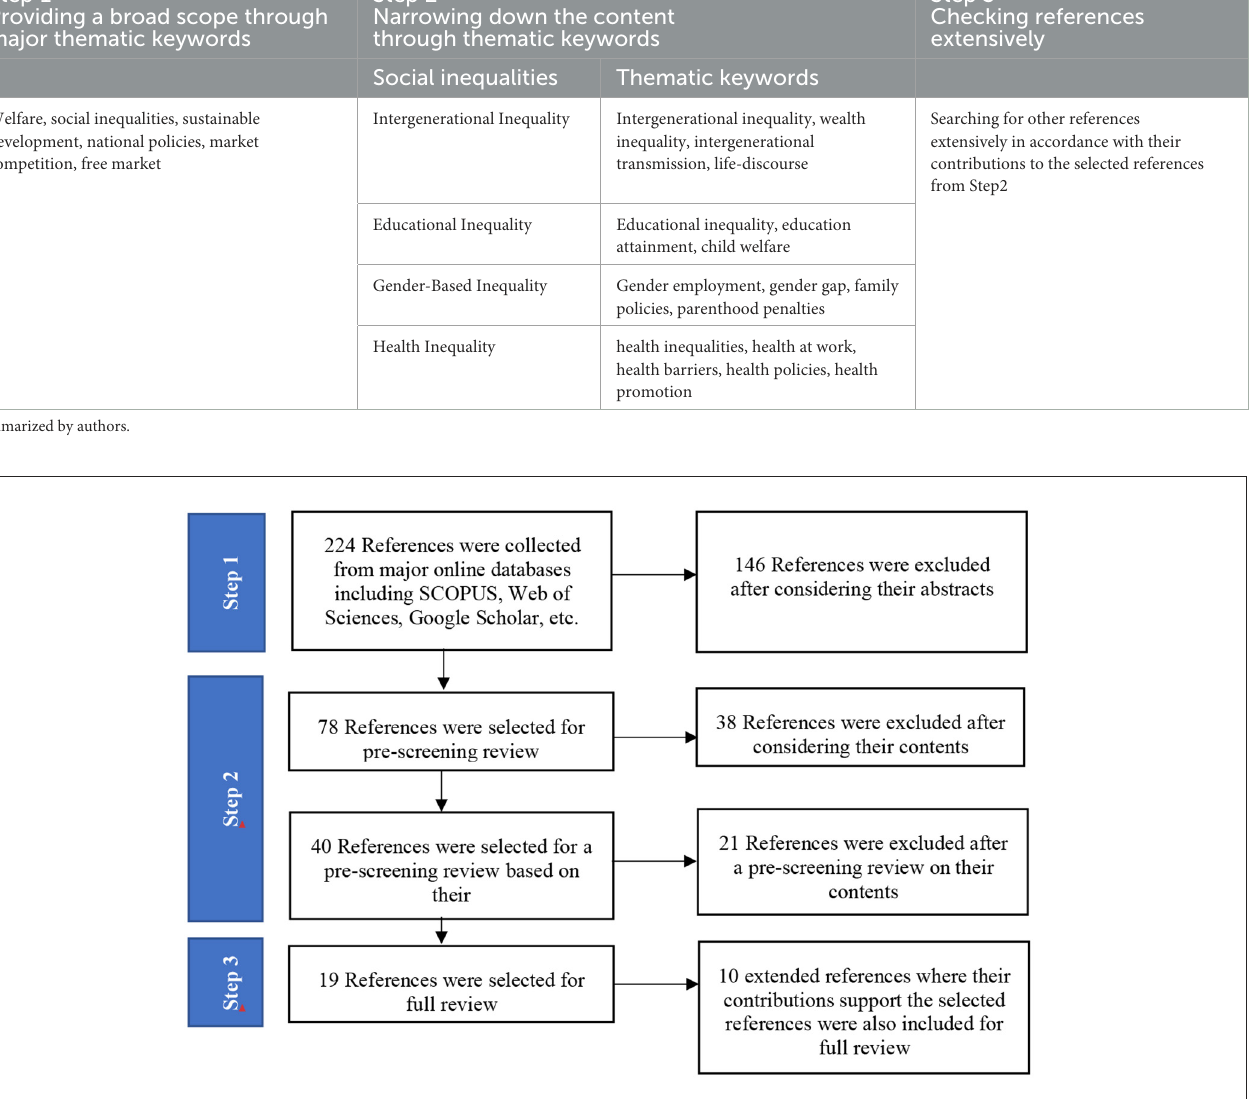
FIGURE1 Process of selecting references for